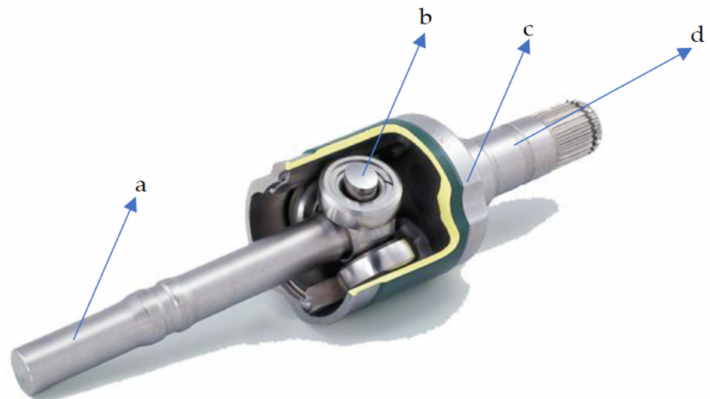
Figure 3. Details of tulip-tripod joint (tripod fixed by splines on the